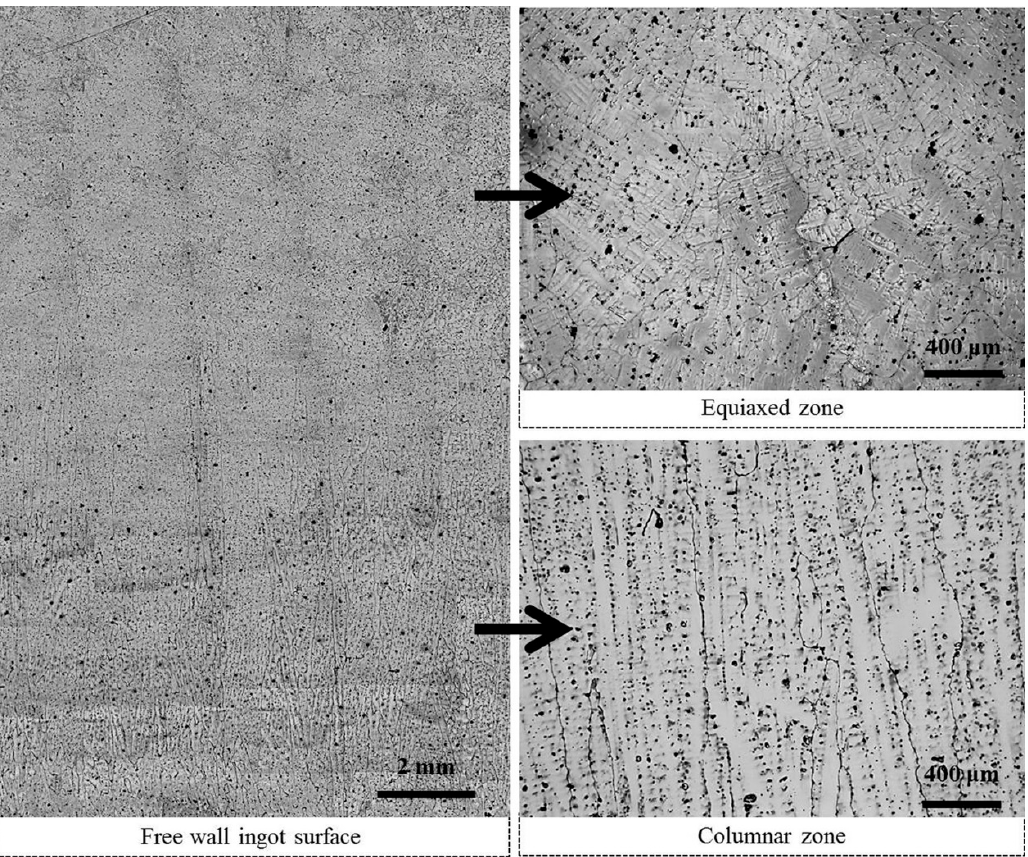
Figure 7. Solidification microstructure of TW-B2.